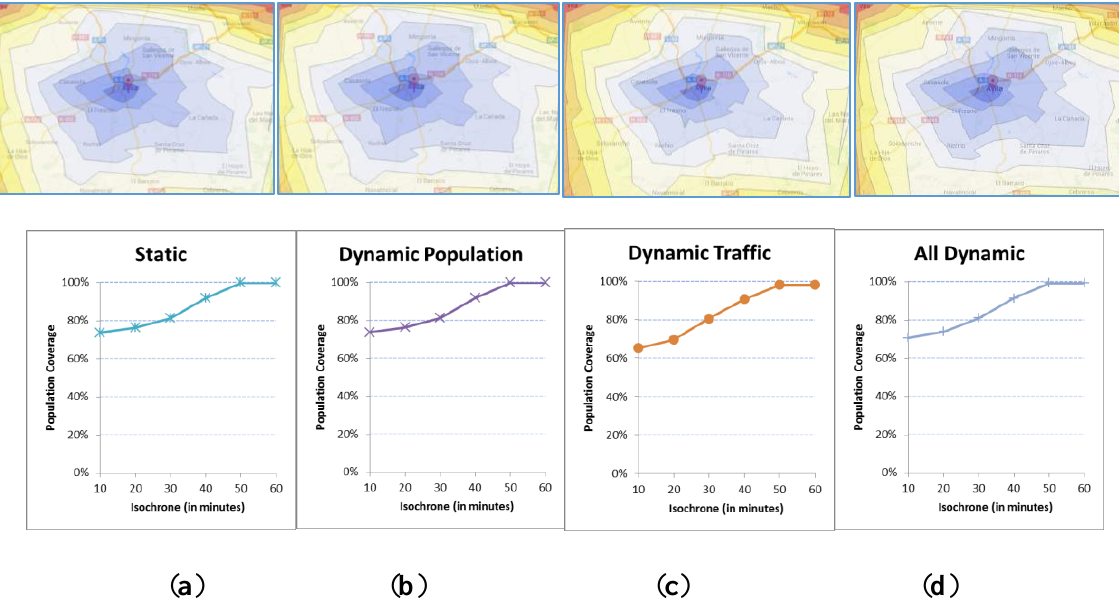
Figure 9. ( a ) Static population and standard times; ( b ) Dynamic population and standard times; ( c ) Static population and dynamic times; ( d ) Dynamic population and dynamic